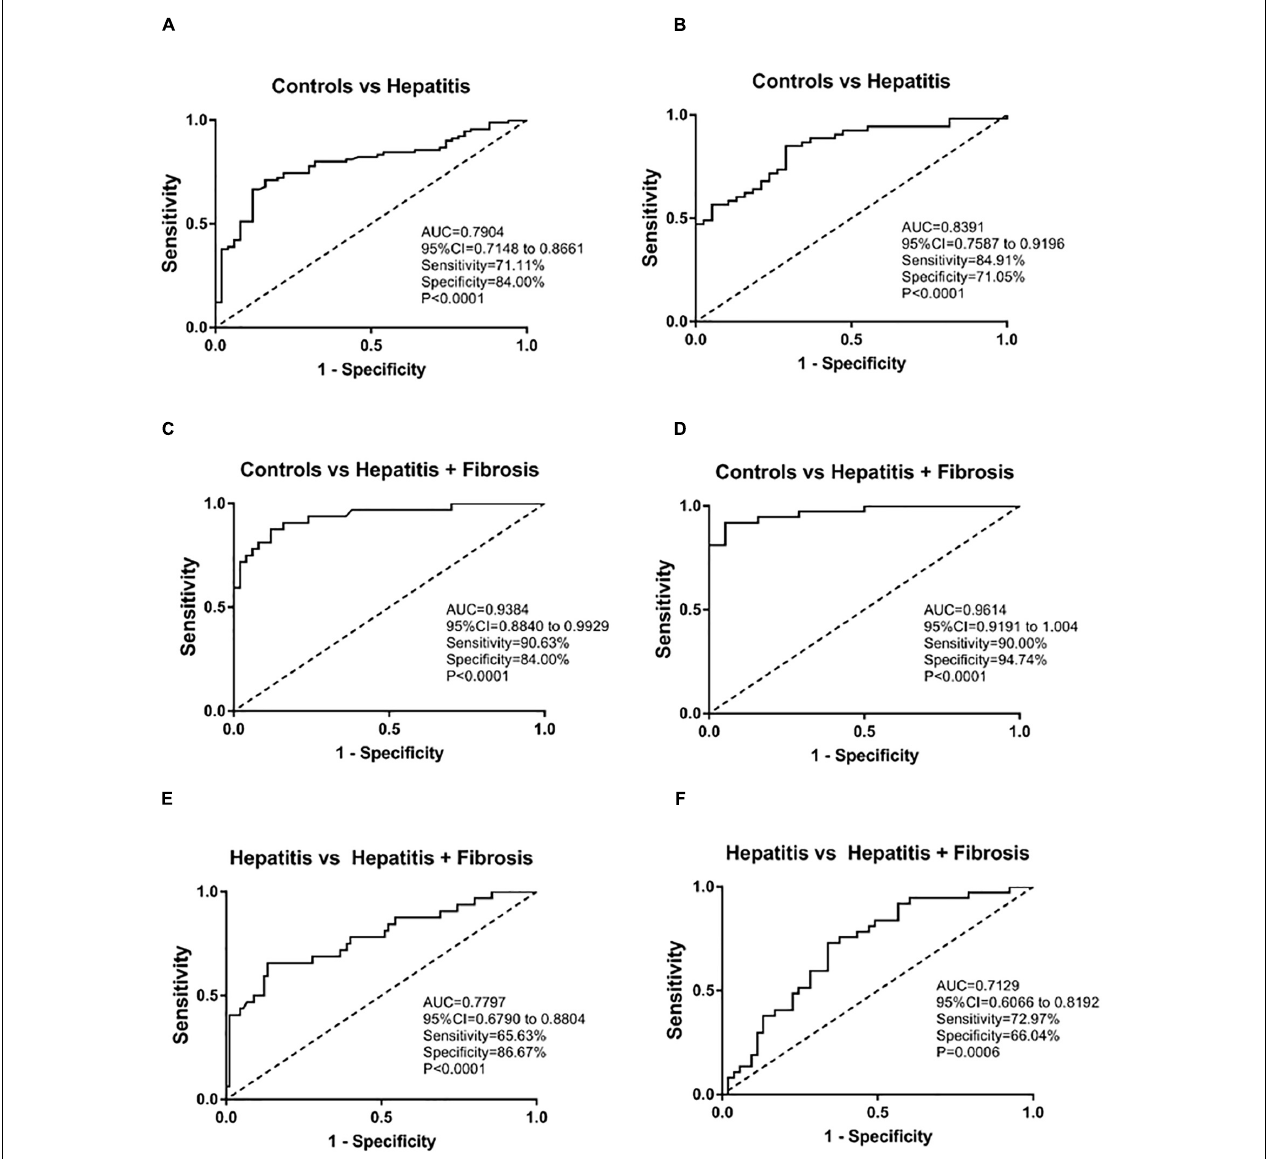
FIGURE 4 | ROC analysis of sTim-3 to determine its diagnostic value for patients with hepatitis and hepatitis with fibrosis. (A) ROC curve of sTim-3 in healthy controls and patients with hepatitis (the first batch of included samples). (B) ROC curve of sTim-3 in healthy controls and patients with hepatitis (the second batch of included samples). (C) ROC curve of sTim-3 in healthy controls and patients with hepatitis and fibrosis (the first batch of included samples). (D) ROC curve of sTim-3 in healthy controls and patients with hepatitis and fibrosis (the second batch of included samples). (E) ROC curve of sTim-3 in patients with hepatitis and hepatitis with fibrosis (the first batch of included samples). (F) ROC curve of sTim-3 in patients with hepatitis and hepatitis with fibrosis (the second batch of included